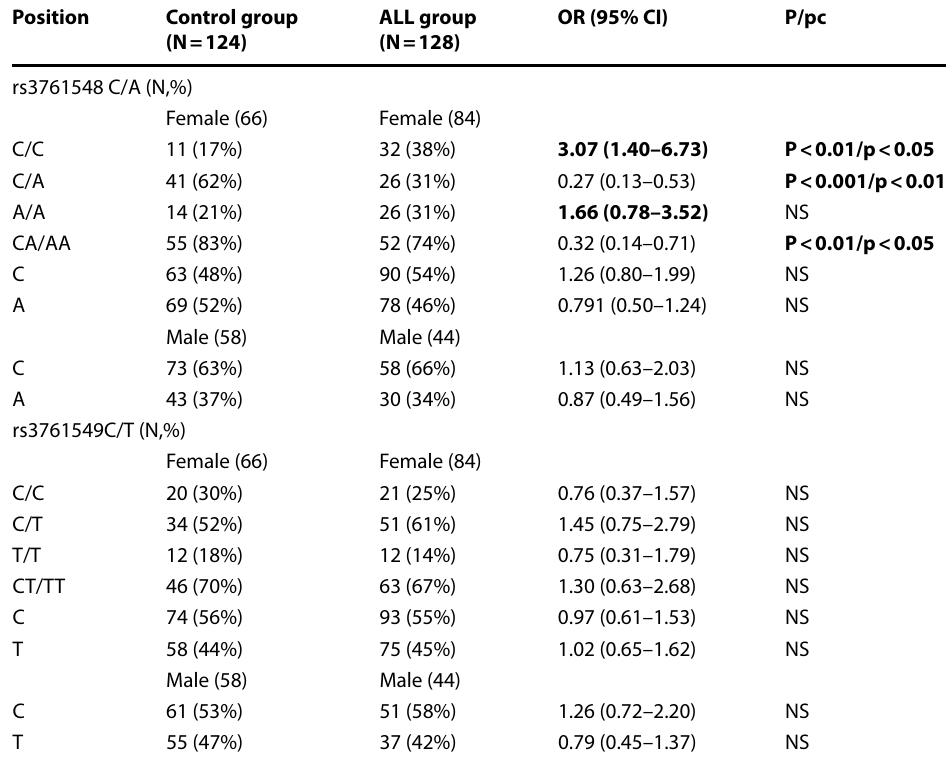
Table 2 Genotype distribution and allelic frequency of